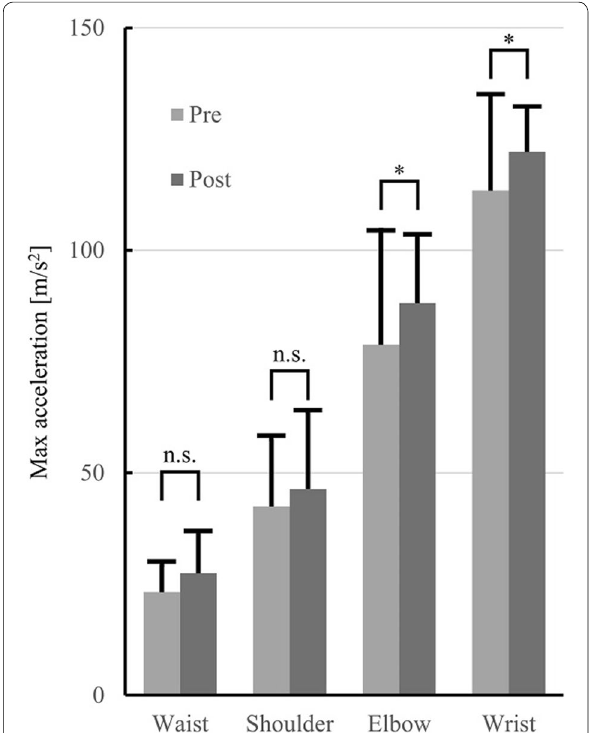
Fig. 6 Variation in maximum acceleration (m/s 2 ). *p values were derived using Wilcoxon signed-rank test (*p < 0.05). n.s. values mean